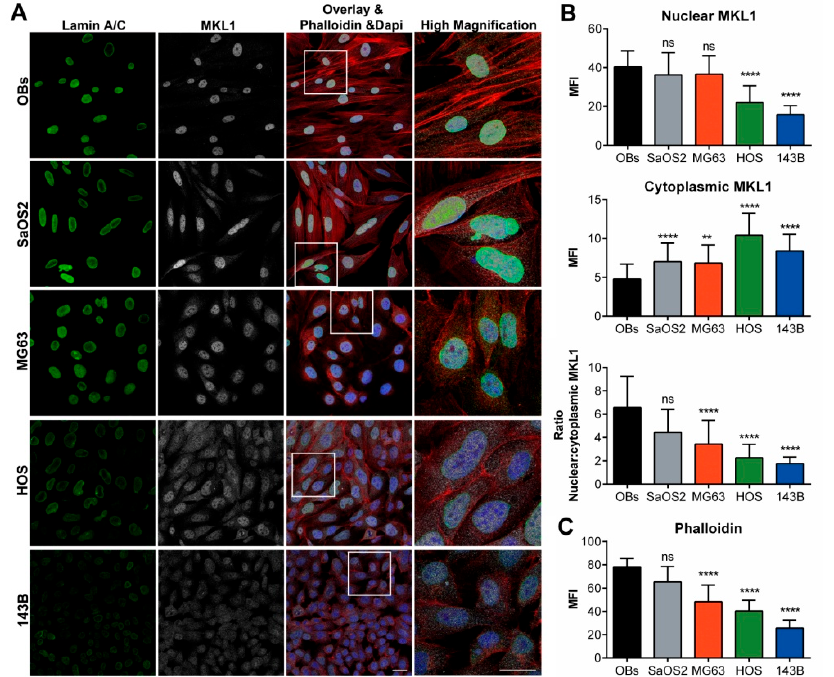
Figure 10. Altered nucleo-cytoplasmic MKL1 shuttling and different polymerization status of actin were differentially observed in osteosarcoma cell lines. ( A ) Subcellular distribution of MKL1 (white), actin (red) and lamin A/C (green) Nuclei were stained with Dapi. Bar: 30 μ m. ( B ) Mean Fluorescence Intensity (MFI) of nuclear (upper panel), cytoplasmic (middle panel) and the ratio nuclear-cytoplasmic (lower panel) MKL1 in OBs and osteosarcoma cell lines. ( C ) Mean Fluorescence Intensity (MFI) of phalloidin in OBs and osteosarcoma cell lines. ** p < 0.01, **** p < 0.001; ns: not